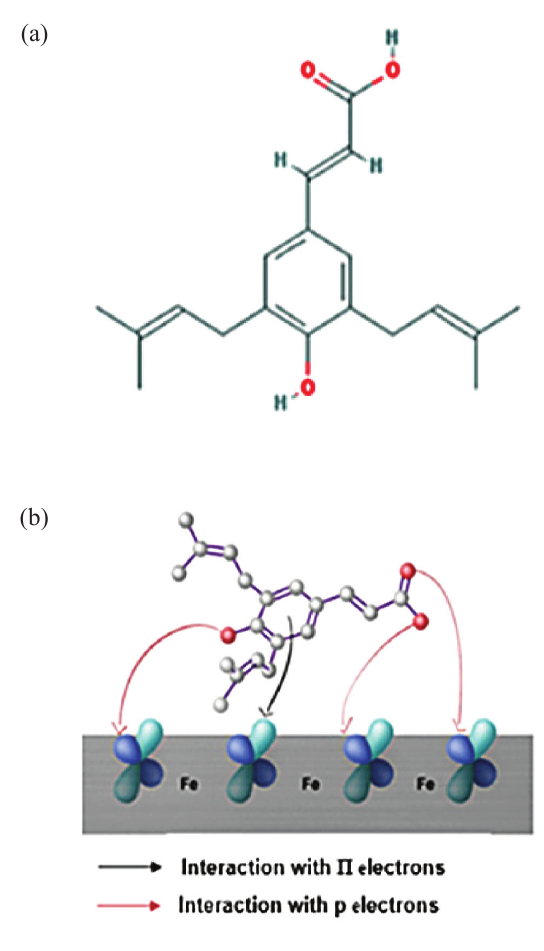
Fig. 5 – (a) acid 3,5-diprenyl-4- hydroxycinnamic, Artepillin C ® , (b) interactions between Artepillin C ® and the metal